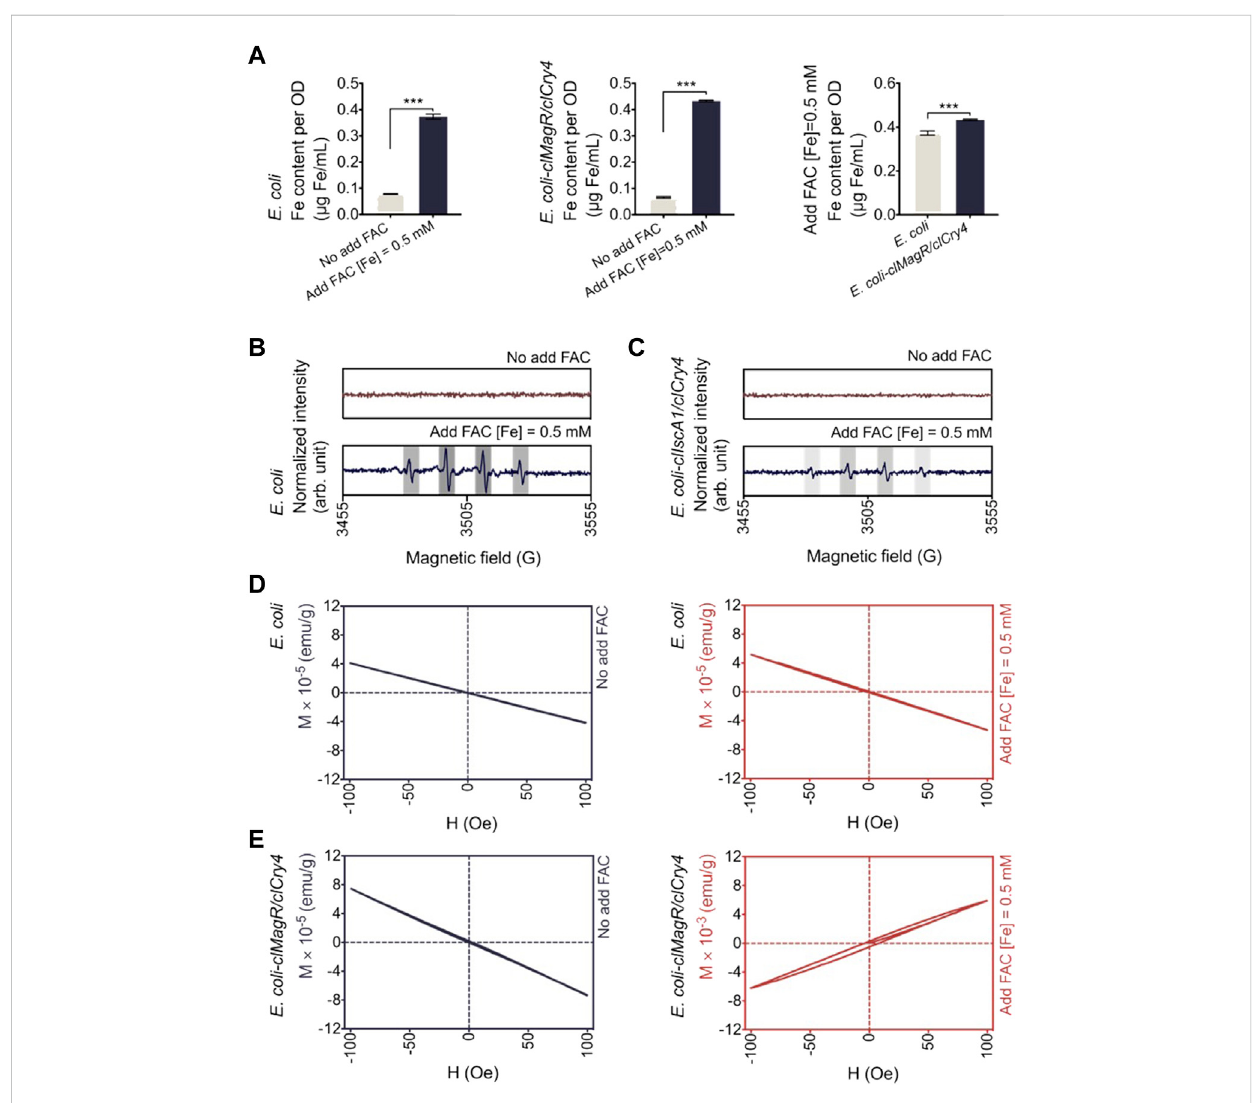
FIGURE 2 Biological effects of exogenous iron on bacteria. (A) Iron content analysis. Data corresponding to iron content were determined by ICP-MS. The intracellularFecontentof E.coli transfectedwith clMagR/clCry4 washigherthanthatofthecontrol.Datawerepresentedasmean±SD( n =3).Statistical signi fi cance was analyzed using the unpaired Student ’ s t-test. *** p < 0.001. (B,C) Hydroxyl radical generation was monitored by ESR measurement. The (cid:129) main quartet signal characteristic for the DMPO-OH adduct is indicated by gray columns. Compared to control E. coli , the quartet signal was also detected at by E. coli transfected with clMagR/clCry4 but at a much lower intensity. Data were normalized for intergroup difference comparison. (D,E) Hysteresisloops(magnetizationMversusapplied fi eldH)of E.coli weremeasuredbySQUIDmagnetometry.Whenculturedintheexogenousironsupply medium, E. coli transfected with clMagR/clCry4 showed detectable magnetic properties (magnetic susceptibility, 0.00625